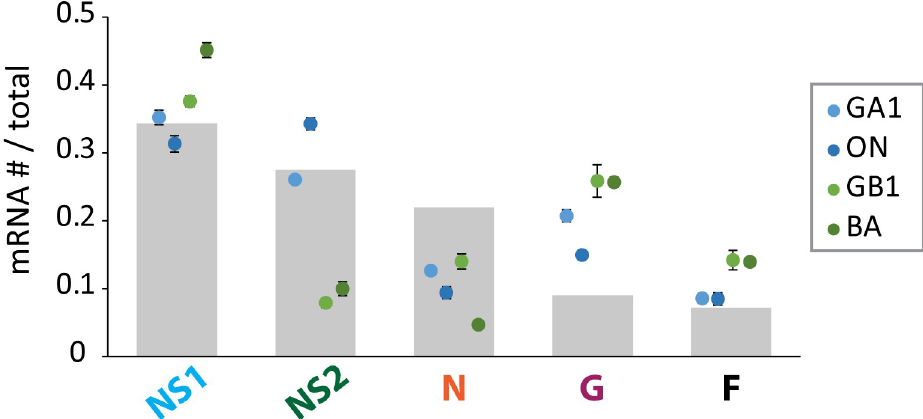
Fig 3. Relative mRNA levels are genotype-specific and non-gradient. Grey bars depict relative mRNA levels expected from an expression gradient resulting from a 20% decrease in transcription at every gene junction. Each dot depicts the mean mRNA # / total mRNA # observed for the indicated species and isolate (RSV/A/GA1Tracy [pale blue]; RSV/A/ON/121301043A [dark blue]; RSV/B/GB1/18537 [light green]; RSV/B/BA/80171 [dark green]) in HEp-2 cells (MOI = 0.01) at steady-state. Steady-state mean relative mRNA levels and standard deviation were calculated using the mean of each relevant time-point (24, 48, 72 hours post-infection). The mean of each time-point was calculated from two independent experiments, and the mean from each experiment was calculated from duplicate measurements as